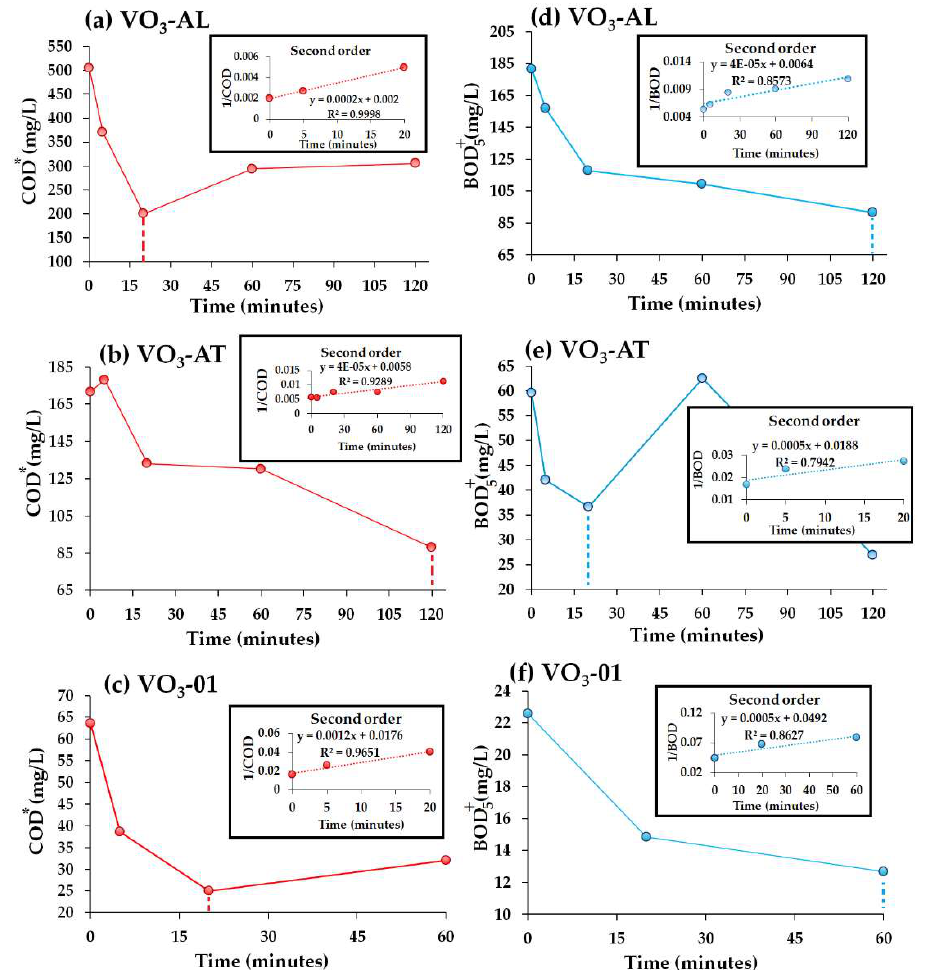
Figure 5. Removal of COD and BOD 5 as function of reaction time. * Chemical Oxygen demand, + 5-day biological oxygen demand. The dotted lines represent the required time to obtain kinetics. Inset: Second order kinetic plot for the removal of COD and BOD 5 .